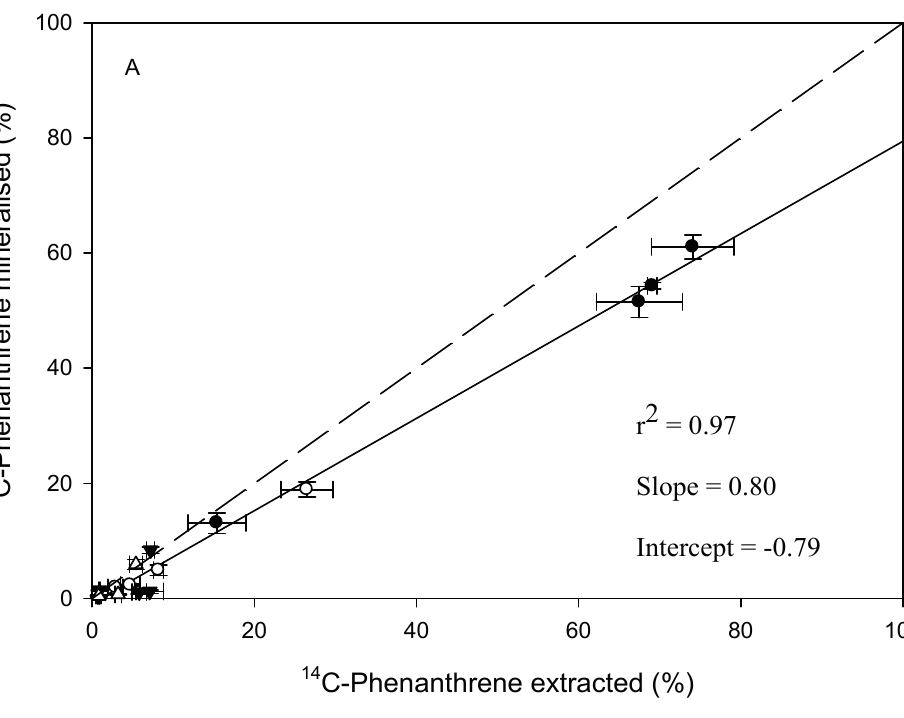
Figure 4. Linear regressions showing the correlation between total extents of 14 C-phenanthrene mineralised and total 14 C-phenanthrene extracted by HPCD in ( A ) non-sterile soil ( B ) sterile soil. Data points represent both AC-amended and controls soils. Dashed lines represent y = x correlation between the two variables. Error bars are SEM ( n = 3).